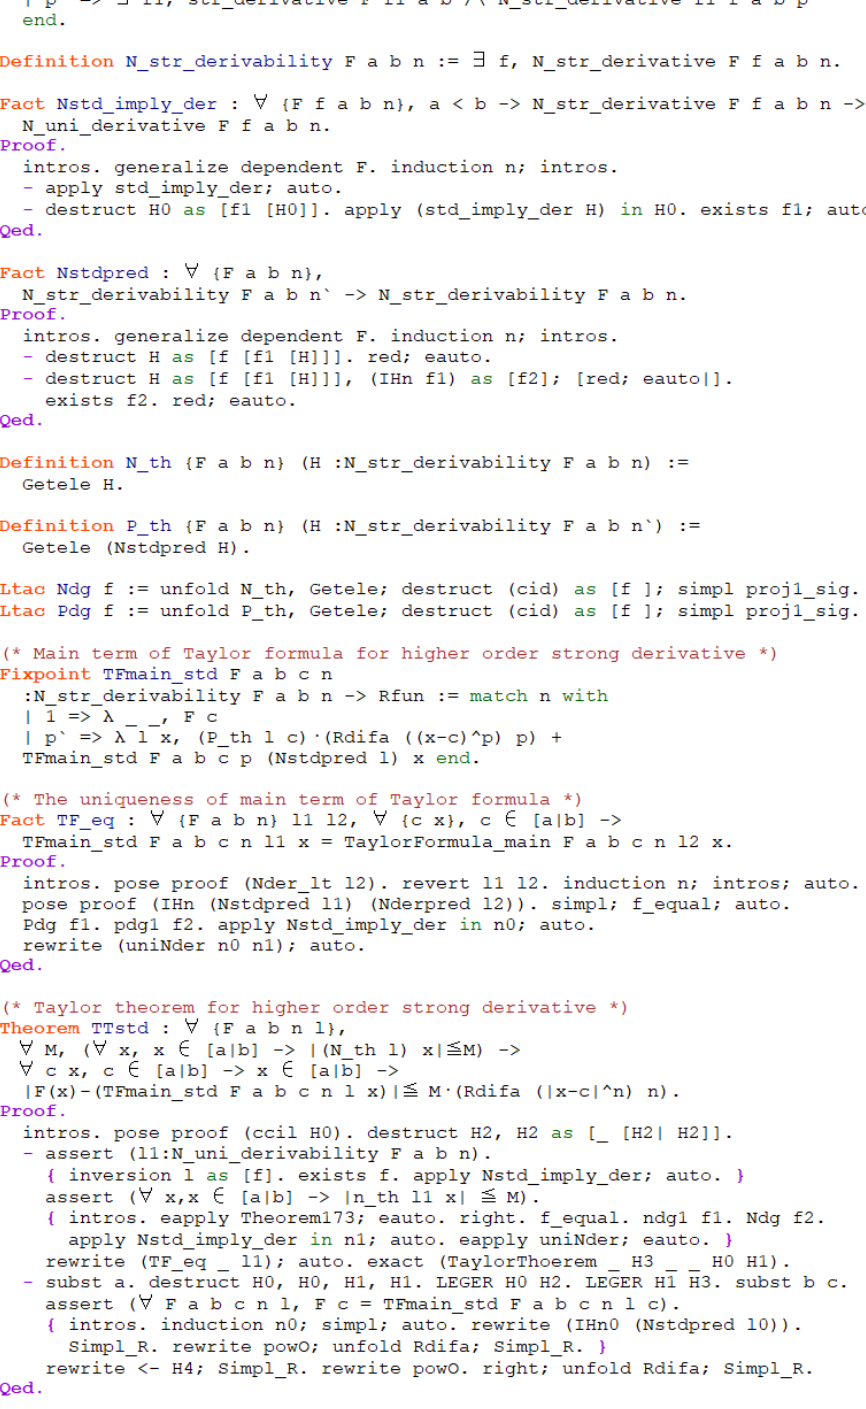
Figure A1. Higher order strong